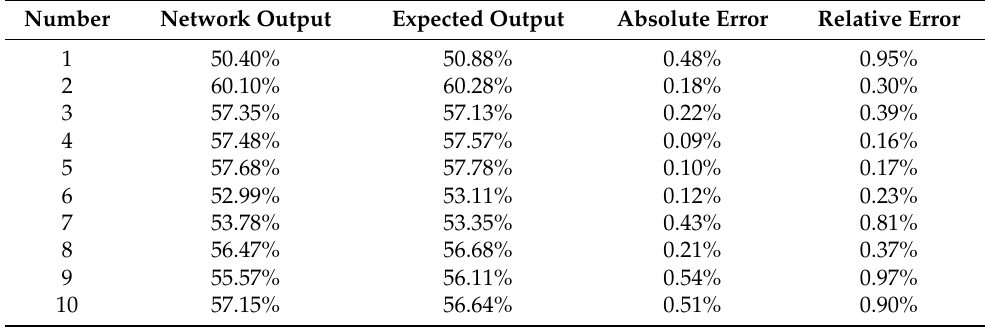
Table 3. GA-BP neural network prediction model simulation prediction data versus desired output